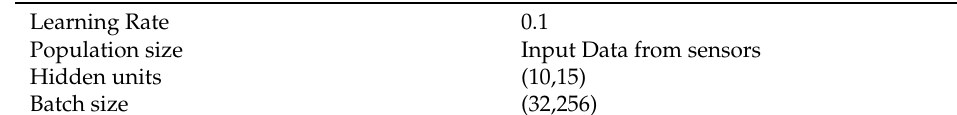
Table 4. Parameters of GWO-PSO Hybrid model.